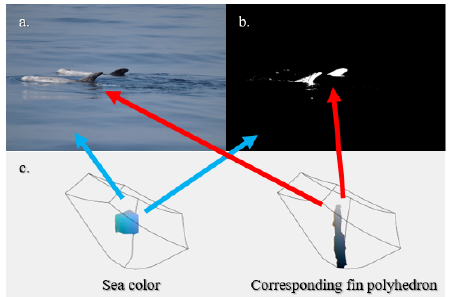
Figure 5. Example of segmentation: ( a ) original image, ( b ) binary mask obtained. White areas are candidate to be fins. ( c ) Qualitative visualization of a model m i in terms of sea color and fin polyhedron. The blue arrows refer to the masked background, the red ones highlight the polyhedron responsible for masking the candidate fins.